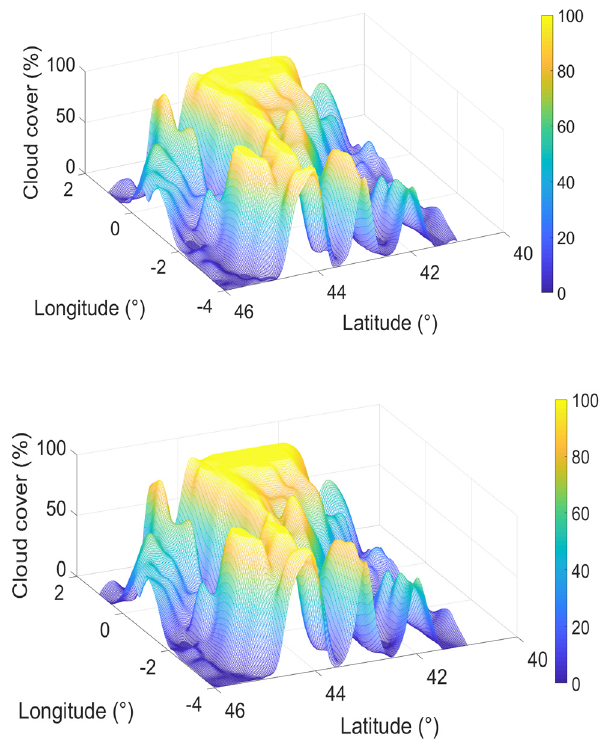
Figure 11. Geographical interpolation of the cloud cover: Result of the spline ( up ) and cubic ( down ) interpolation.